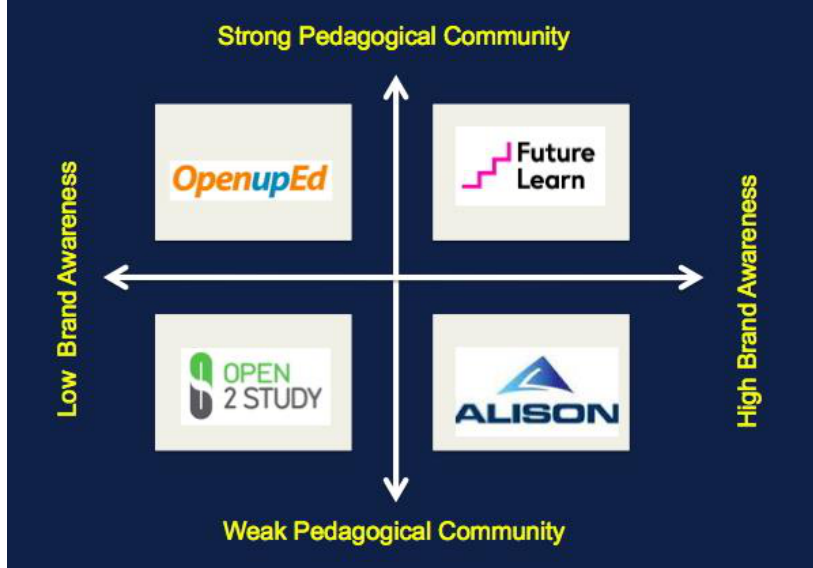
Figure 3: Example decision